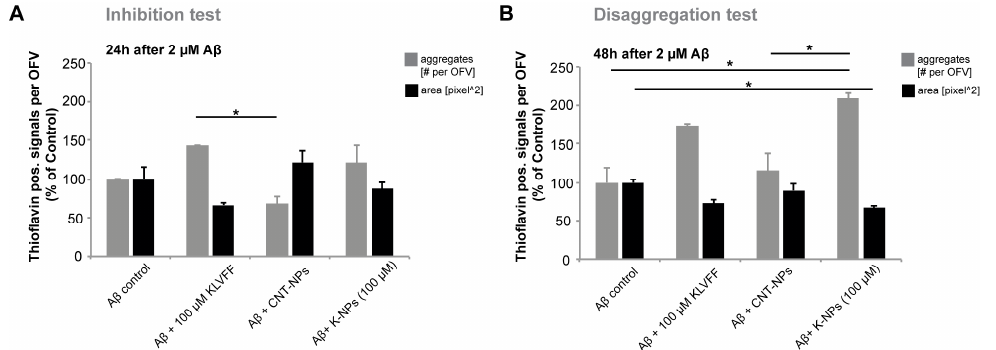
Figure 4. NPs delivering an equivalent of 100 µ M KLVFF peptides reduce A β (1–42) aggregation in vitro. ( A , B ) Hippocampal neurons were treated for either 24 h ( A ) or 48 h ( B ) with 2 µ M A β (1–42) , and the number and area of A β aggregates were visualized by Thioflavin staining and measured in three optic fields of view (OFV) 24 h after addition of 100 µ M KLVFF peptides, CNT- NPs, or NPs delivering the equivalent of 100 µ M KLVFF. ( A ) Regarding the area, no significant changes were observed after 24 h treatment (one-way ANOVA, p = 0.115). Regarding the number of A β aggregates per OFV, a significant di ff erence was found (one-way ANOVA, p = 0.044). Tukey post hoc analysis revealed a significantly higher number of aggregates in cells treated with 100 µ M KLVFF peptides compared to cells treated with CNT-NPs ( p = 0.038). ( B ) After 48 h exposure to A β (1–42) , regarding the area, significant changes were observed (one-way ANOVA, p = 0.042). Tukey post hoc analysis revealed a significant decrease in the area of aggregates in cells treated with NPs delivering 100 µ M KLVFF peptide compared to cells treated with A β (1–42) only ( p = 0.046). Regarding the number of A β aggregates per OFV, a significant di ff erence was found (one-way ANOVA, p = 0.002). Tukey post hoc analysis revealed a significantly higher number of aggregates in cells treated with NPs delivering 100 µ M KLVFF peptide compared to cells treated with A β (1–42) only ( p = 0.023), and a significantly higher number of aggregates in